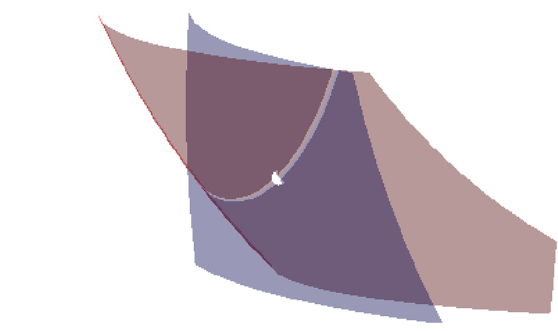
Figure 8. Partial enlarged view of intersection line of torus.